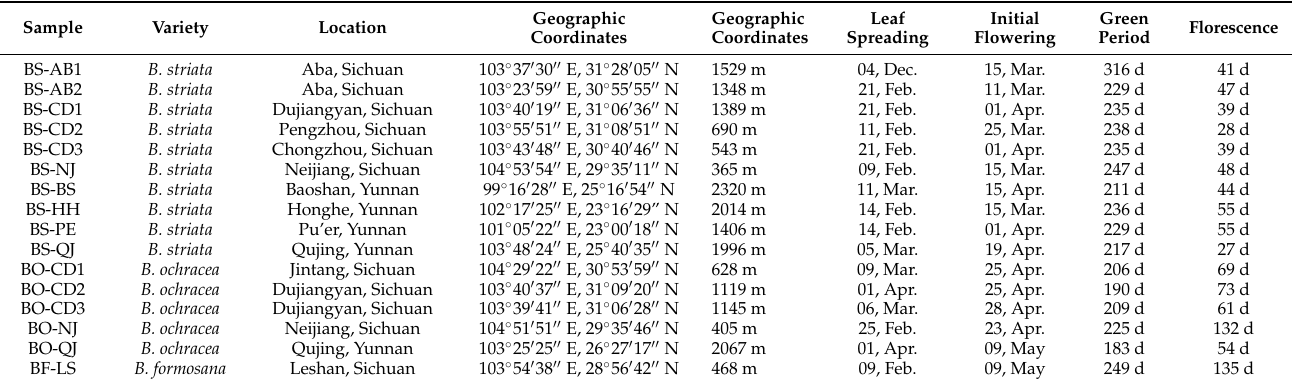
Table 1. Collection of germplasm resources.